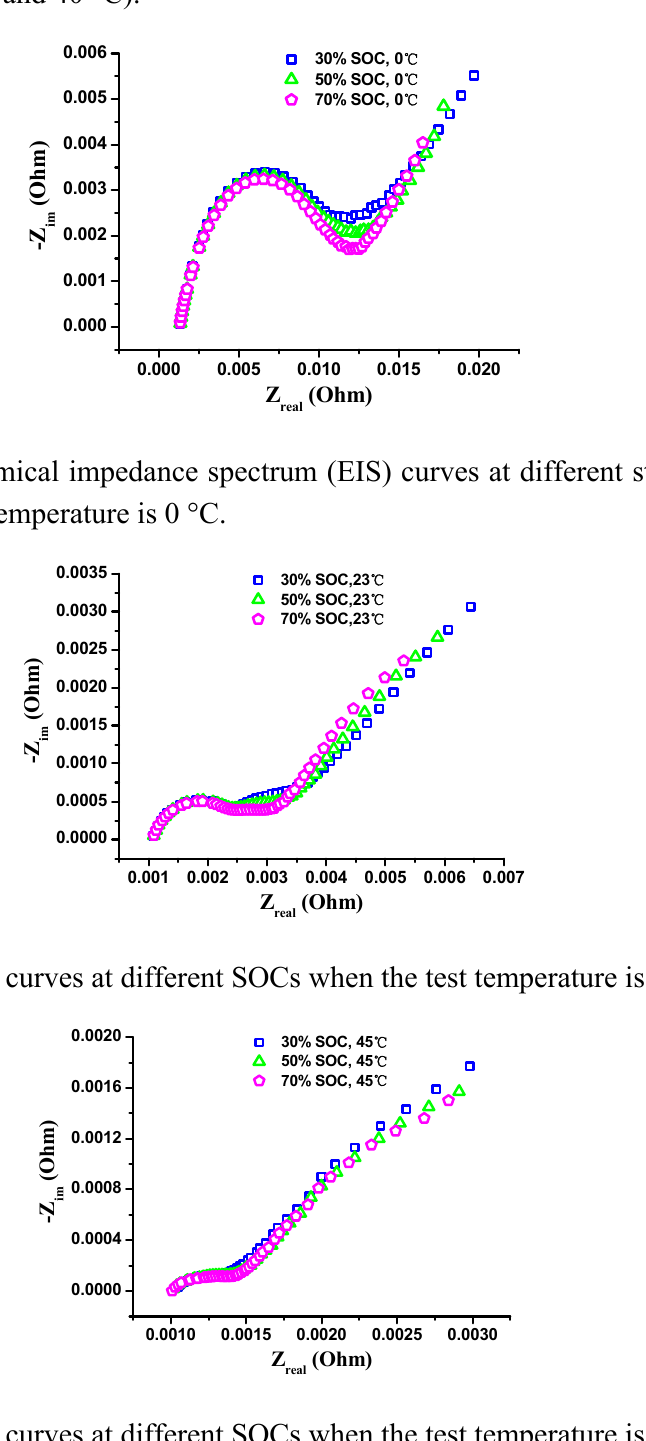
Figure 15. EIS curves at different SOCs when the test temperature is 45